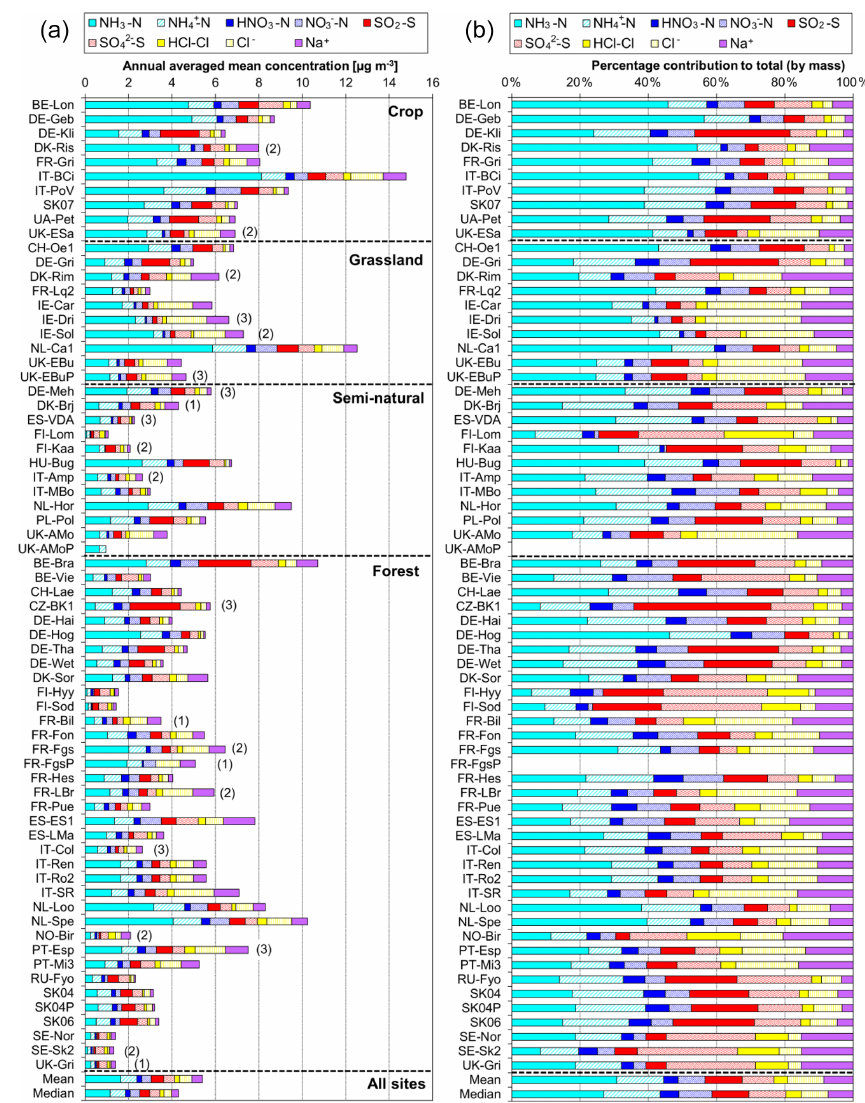
Figure 7. (a) Annual averaged gas and aerosol concentrations (2007–2010) of sites in the NEU DELTA ® network, grouped according to ecosystem type: crops ( n = 10), grassland ( n = 9 + 1 parallel), semi-natural ( n = 11 + 1 parallel), and forests ( n = 34 + 2 parallel). (b) Per- centage composition of gas and aerosol components measured at NEU DELTA ® network sites ( n = 64 + 4 parallel sites) (mean of all annual mean concentrations from 2007 to 2010). Years with < 7 months of data, including 2006, are excluded. Where the number of years con- tributing to the annual average is < 4, the number is shown in brackets beside the site data. Ca 2 + and Mg 2 + data are not included as these were mostly at or below the limit of detection. Replicated DELTA measurements are made at four sites: FR-Fgs/FR-FgsP (NaCl instead